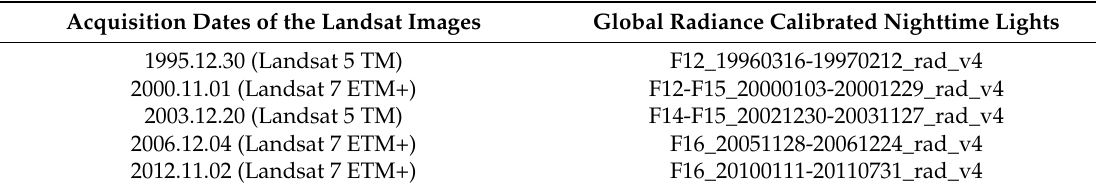
Table 1. Landsat images (122/044) and global radiance calibrated nighttime light data.